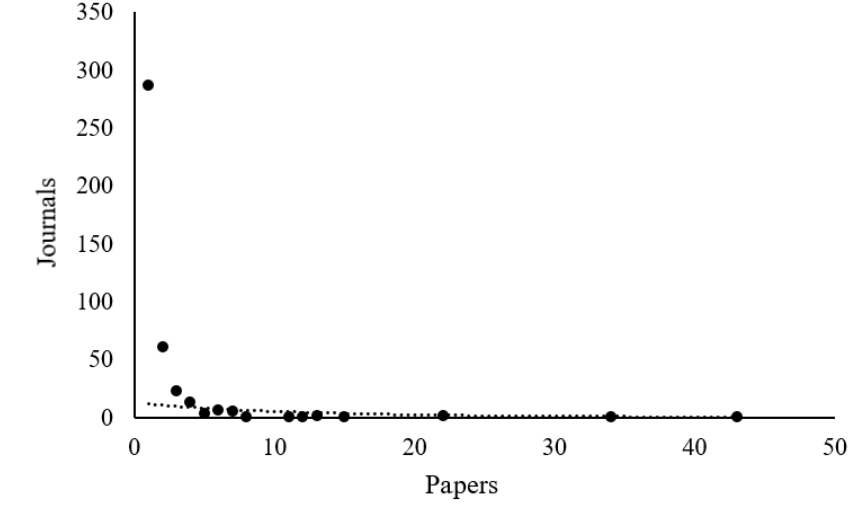
Figure 4. Analysis of linear regression between the number of journals (Y axis) and papers (X